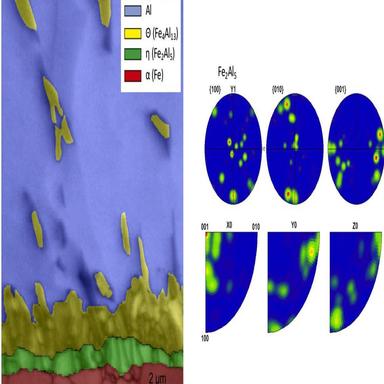
EBSD map obtained at the joint interface showing the distinct phases that were identified, together with the pole figures and inverse pole figures for the η and θ phases keeping the Z axis normal to the sample surface.